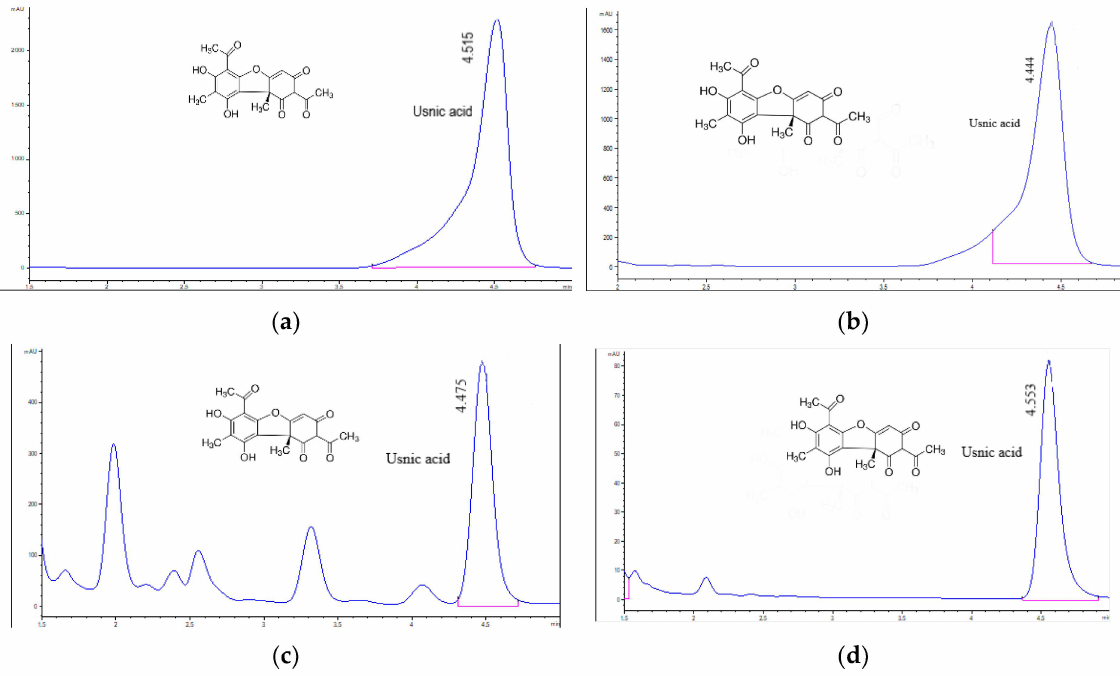
Figure 1. Chromatograms of usnic acid standard ( a ), m UBA ( b ), m UBE ( c ), m UBW ( d ). The red lines mark the significant peak